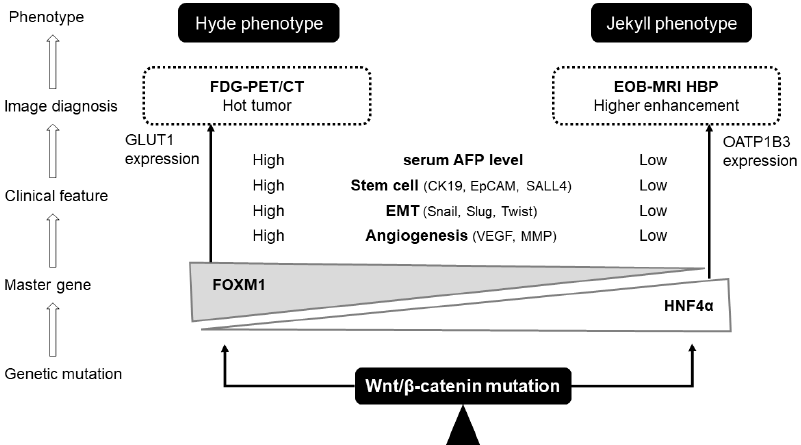
Figure 4. Non-invasive detection of Wnt/ β -catenin activation using imaging biomarkers. HNF4 α and FOXM1 , which are located downstream of the Wnt/ β -catenin canonical pathway, define the phenotype of HCC cells. The Jekyll phenotype with well differentiation and suppressed metastasis and vascular invasion is strongly associated with high expression of HNF4 α . HNF4 α promotes the expression of OATP1B3, and we can recognize as iso to higher enhancement intrahepatic nodules in the hepatobiliary phase of Gd-EOB-DTPA-enhanced MRI. The Hyde phenotype with poorly differentiation and massive metastasis and vascular invasion, is strongly associated with high expression of FOXM1 . FOXM1 promotes the expression of GLUT1 and may be recognized as a hot nodule in FDG-PET/CT images.